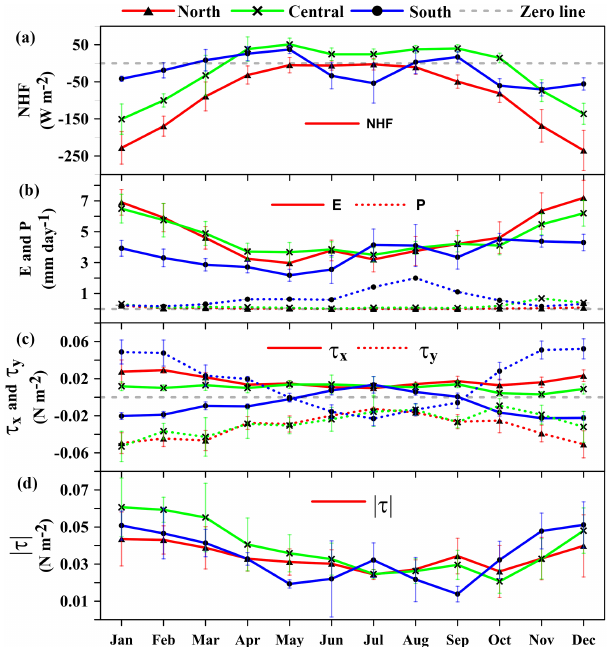
Figure 5. Monthly climatology of (a) NHF, (b) evaporation and precipitation, (c) eastward ( τ x ) and northward ( τ y ) component of wind stress, and (d) magnitude of the wind stress ( | τ | ) . South, cen- tral, and north regions are represented by the changes at 14, 21, and 27 ◦